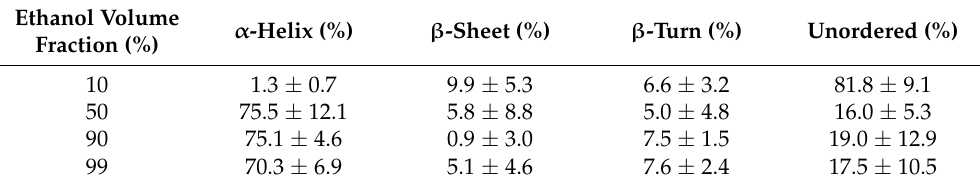
Table 1. Fractions of secondary structures of GL13K in ethanol solutions estimated by CDPro.